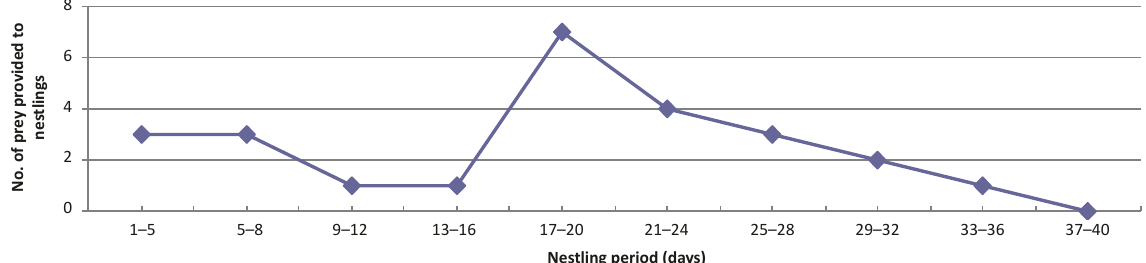
Figure 2. Number of prey brought to the nestlings at morning or eveing or average when both observed the same day.